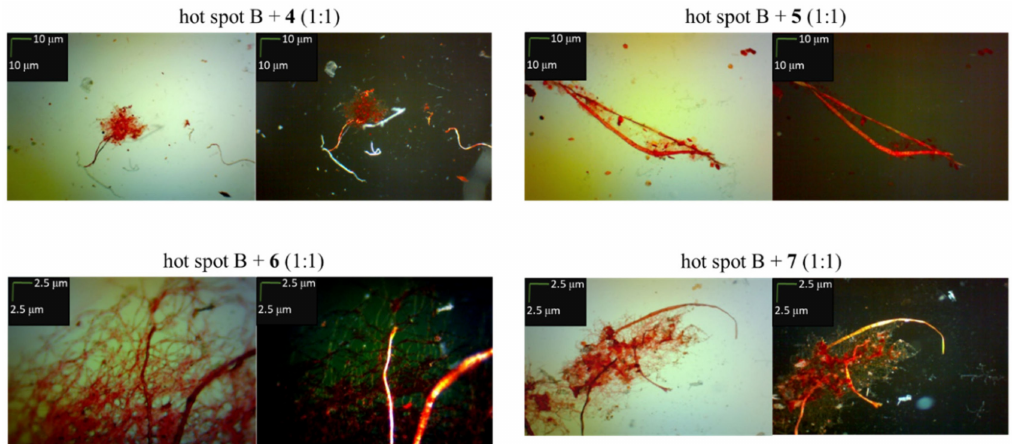
Figure 2. ( a ) UV spectra of mixtures (1:1) of hot-spot A with one of the peptides 1 – 3 and hot-spot B with one of the peptides 4 – 7 in the presence of Congo Red (CR). The spectra show results obtained on the fourth day of incubation; ( b ) fluorescence intensity spectra of mixtures (1:1) of hot-spot A with one of the peptides 1 – 3 and hot-spot B with one of the peptides 4 – 7 in the presence of Thioflavin T (ThT), wavelength = 485 nm, fourth day of incubation; ( c ) pictures of mixtures (1:1) of hot-spot A with one of the peptides 1 – 3 and hot-spot B with one of the peptides 4 – 7 , without a polarized filter (left side) and with a polarized filter (right side). Scale bars, 10 µ m. In all cases, the samples were taken for microscopic examination on the fourth day of incubation.